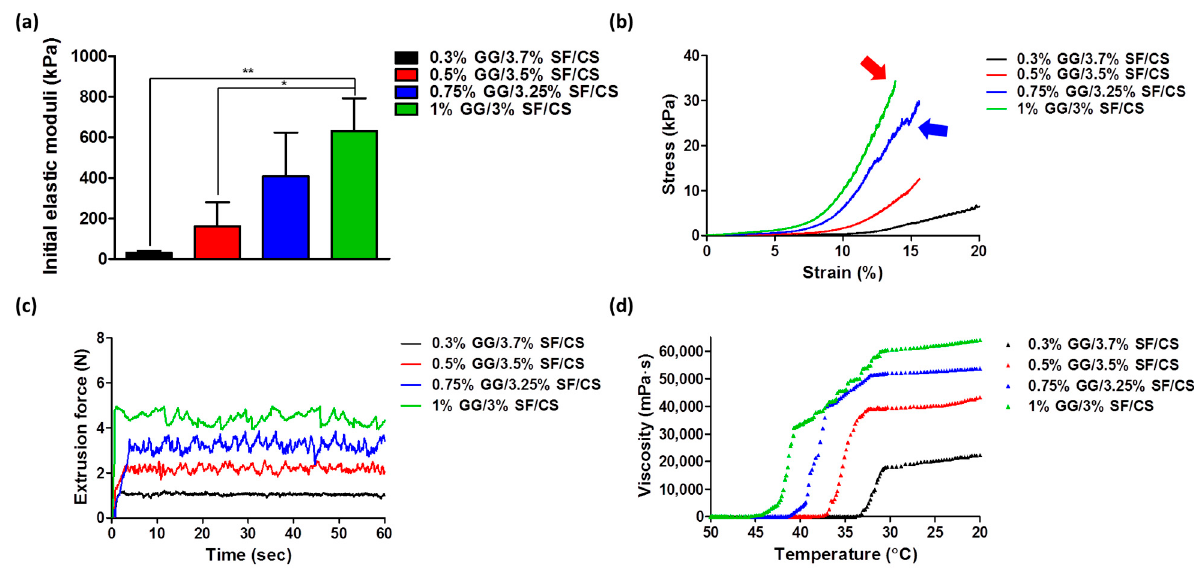
Figure 4. Mechanical characterization of the hydrogels: ( a ) initial elastic modulus at 5–10% strain; ( b ) stress–strain curve (s–s curve) of the hydrogels analyzed at the speed of 2 mm/min with a load cell of 10 N; ( c ) extrusion force analyzed using a 1 mL syringe capped with a needle, texture analyzer at a speed of 20 mm/min, and load cell of 20 N; and ( d ) viscosity analyzed at the temperature range from 50 °C to 20 °C (values are mean ± SD, n = 5, p < 0.01 (**) and p < 0.001 (***)).